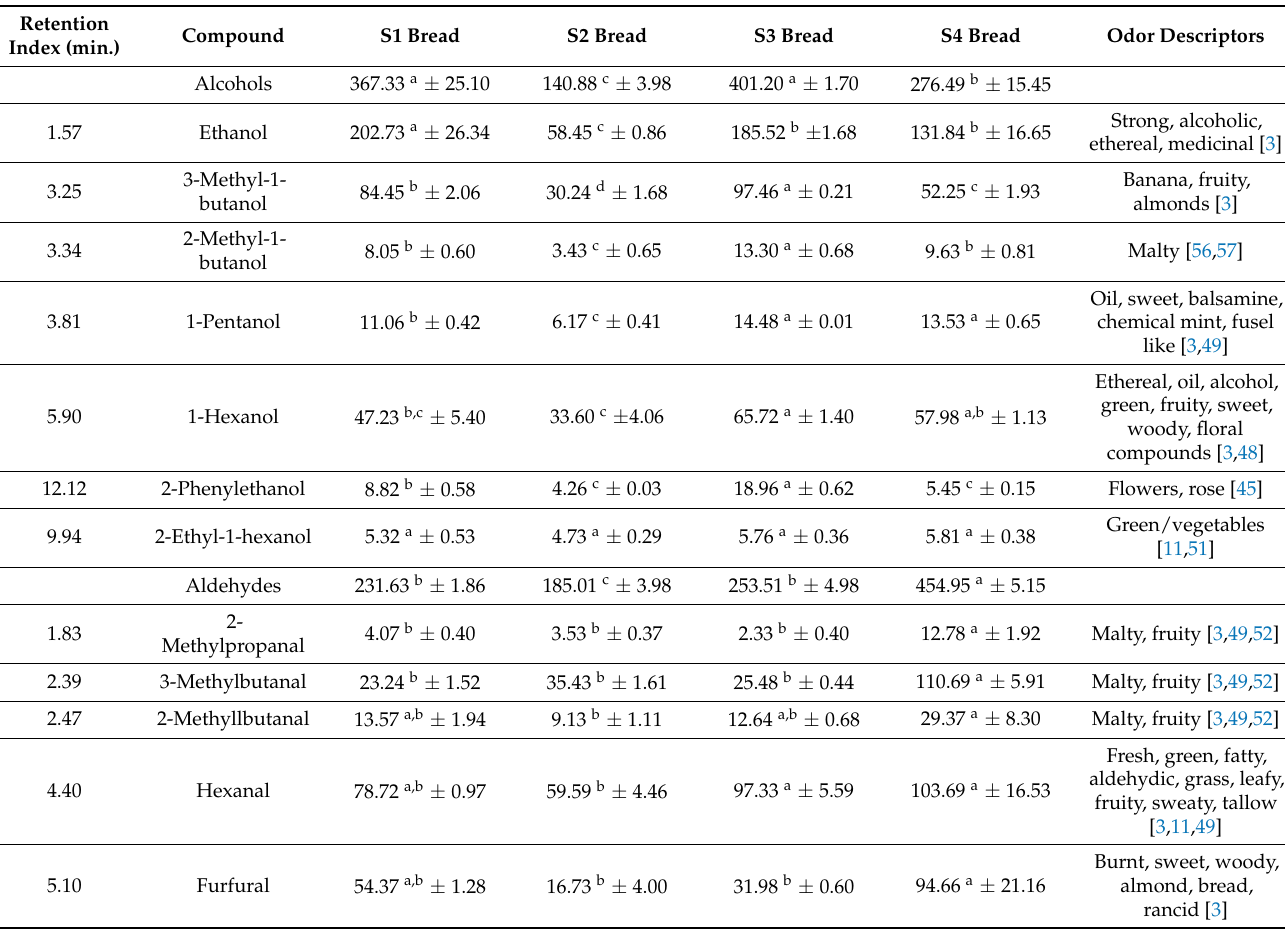
Table 5. Volatile organic compounds (ng/g) in bread obtained from different sourdoughs (S1, S2, S3, and S4). Retention Index